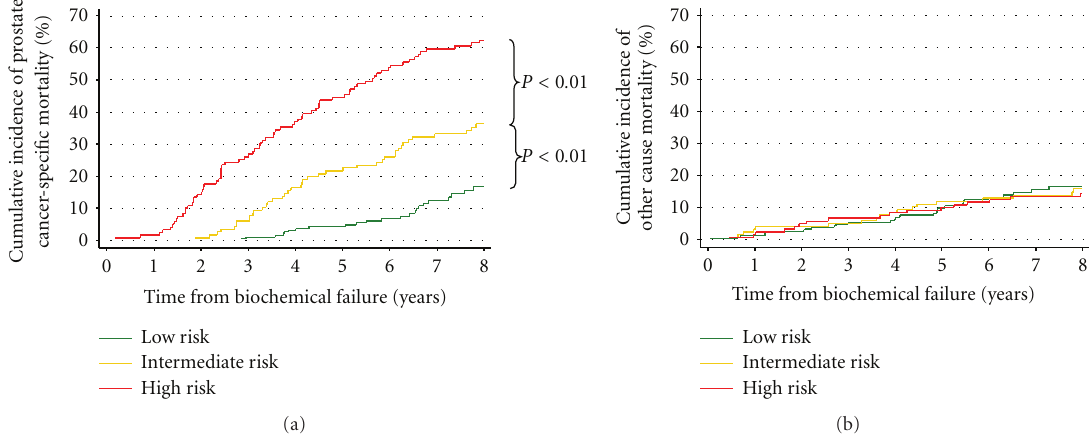
Figure 2: Mortality after biochemical failure for the most predictive post-treatment failure category (BFRC) stratification scheme. (a) Cumulative incidence of prostate cancer-specific mortality. (b) Cumulative incidence of other cause mortality.